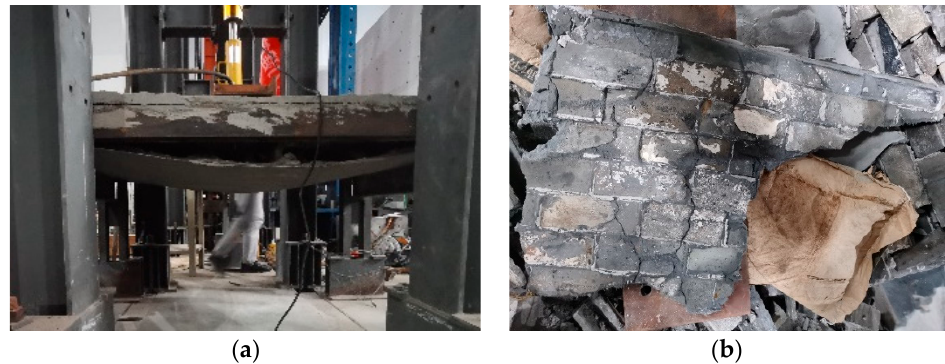
Figure 12. Ductile damage of specimen HDC2. ( a ) Downward deflection of the lower HDC surface; ( b ) lower HDC surface falling off.